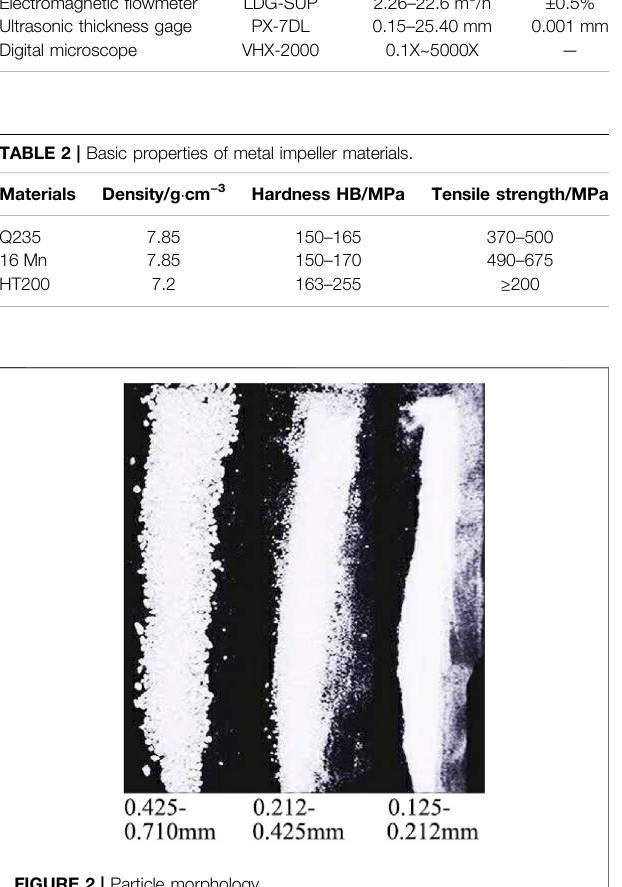
FIGURE 2 | Particle